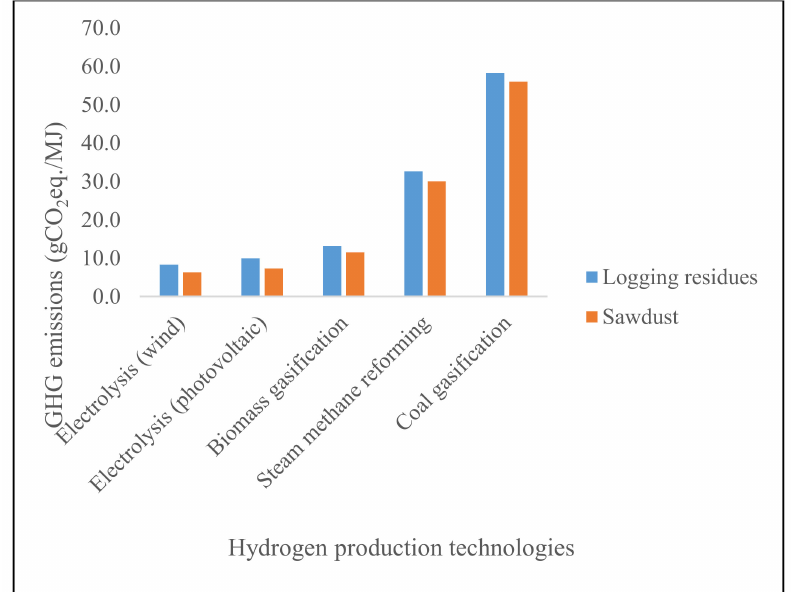
Figure 4. Change in HVO life cycle GHG emissions using renewable and non-renewable sources for hydrogen